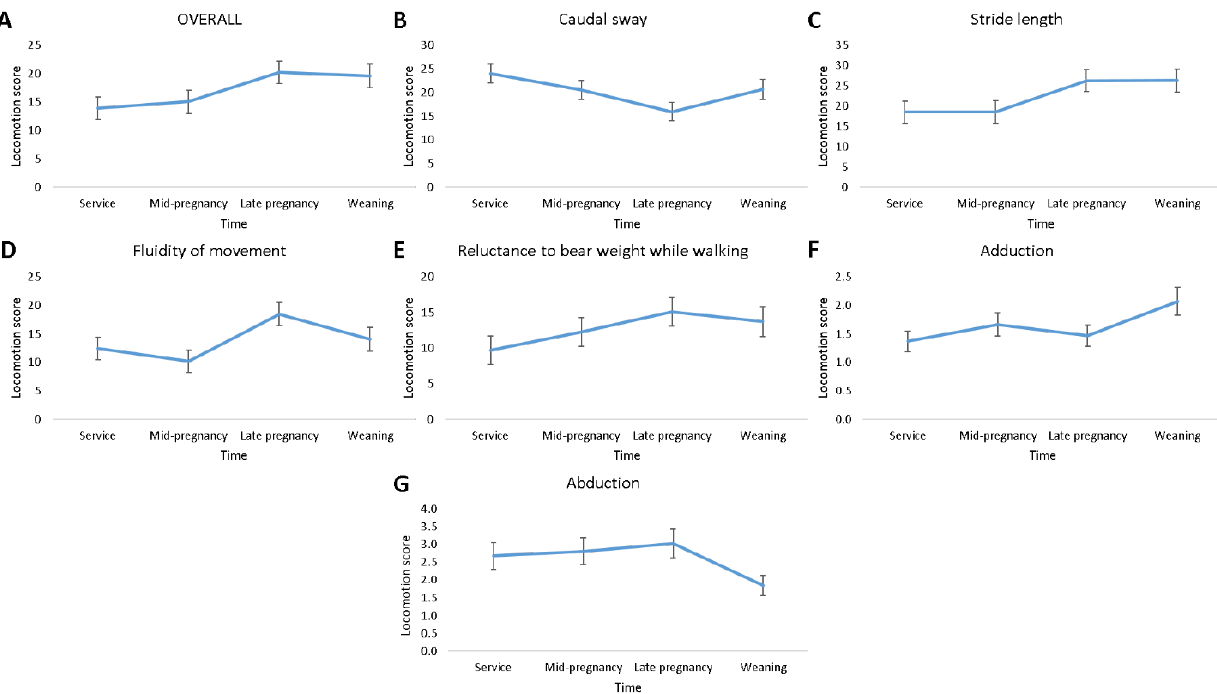
Figure 2. Plots of locomotion score least square mean ± standard error changes over time for OVERALL ( A ), caudal sway ( B ), stride length ( C ), fluidity of movement ( D ), reluctance to bear weight while walking ( E ), adduction ( F ), and abduction ( G ) in 51 gilts (n = 8 replicates).